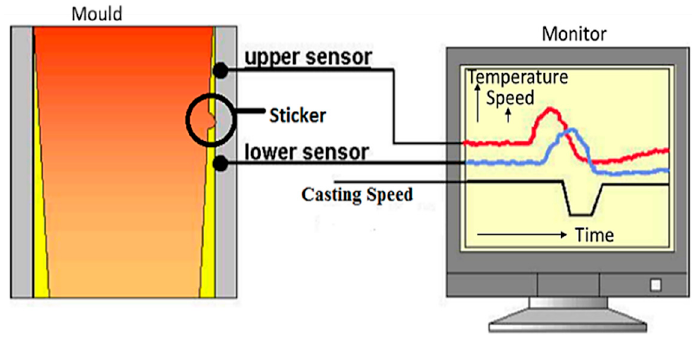
Figure 2. Temperature sensor measurements display.